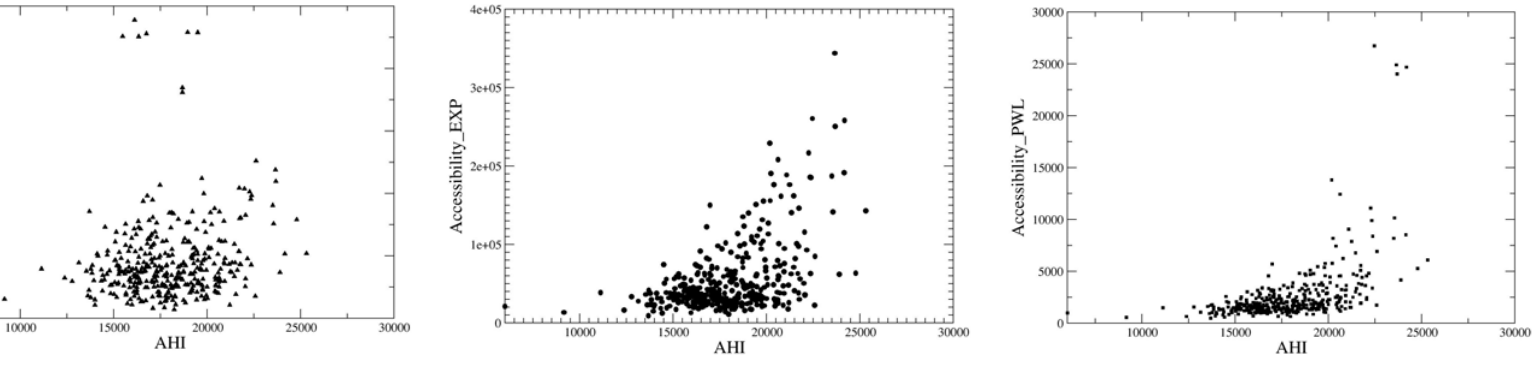
Figure 5. Scatter plot of accessibility indicators versus municipal AHI, in the case of approaches based on travel cost (on the left), and on spatial interaction models with impedance function in exponential (on the middle) and power (on the right)